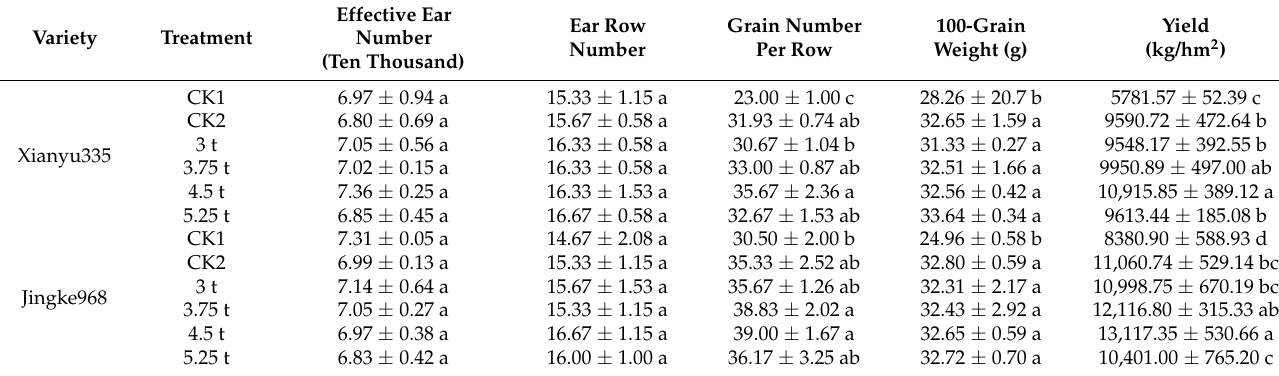
Table 1. Effects of the carbon-based fertilizer on the maize yield and its